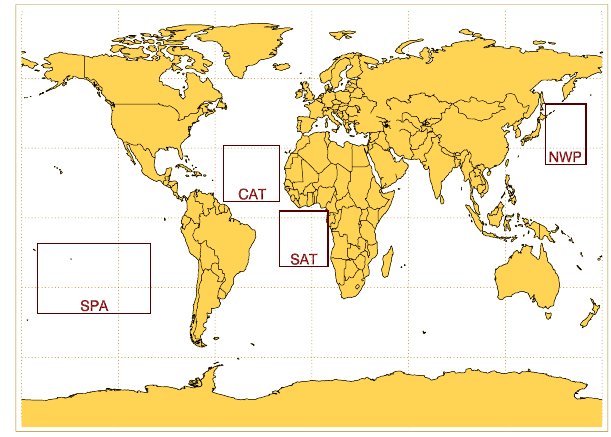
Fig. 16. Four regional study